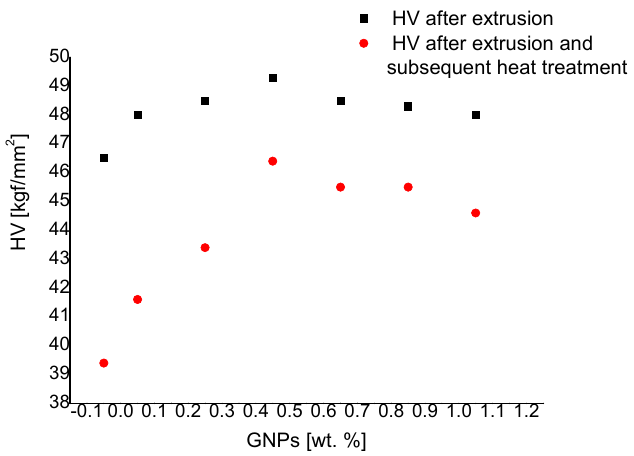
Figure 2. Microhardness in Al matrix/GNPs composites.